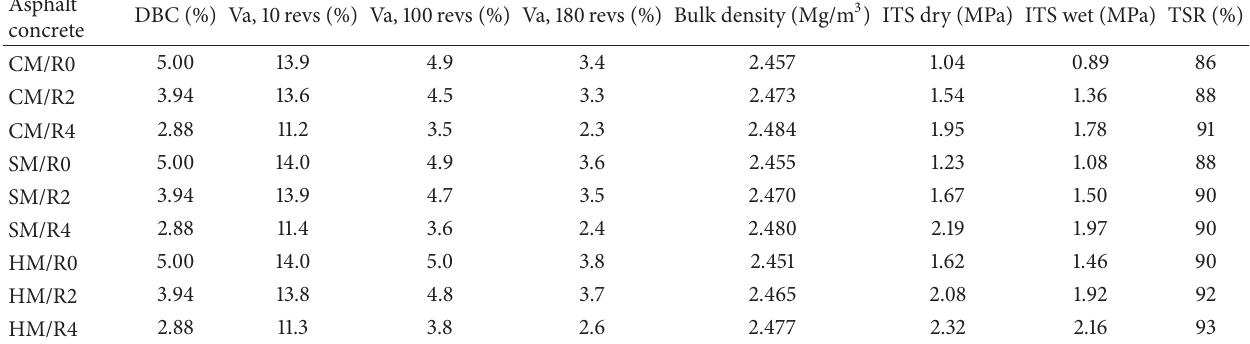
Table 4: Physical and mechanical properties of the hot mix